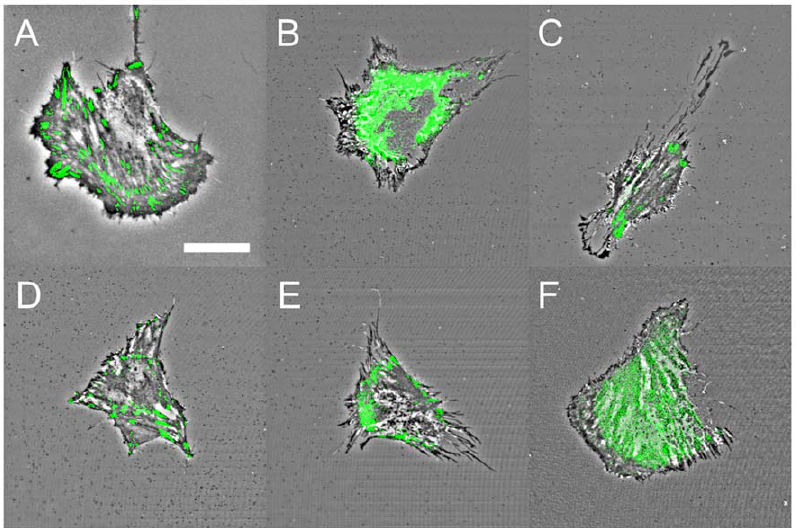
Figure 6. Overlay of IRM imaging and vinculin expression after 60 mins. Simultaneous IRM and fluorescence imaging of live cells expressing Vinculin-EGFP after exposure to inhibitors for 60 min. ( A ) Control (scale bar=20 m m and applies to all), ( B ) Cyt-D, ( C ) nocodazole, ( D ) Y-27632A, ( E ) ML-7 and ( F ) blebbistatin treated cells. Cells treated with nocodazole, Y27632 and ML7 posses smaller but point-like FA structures, similar to the control. Vinculin becomes diffuse after treatment with CytD and blebbistatin.